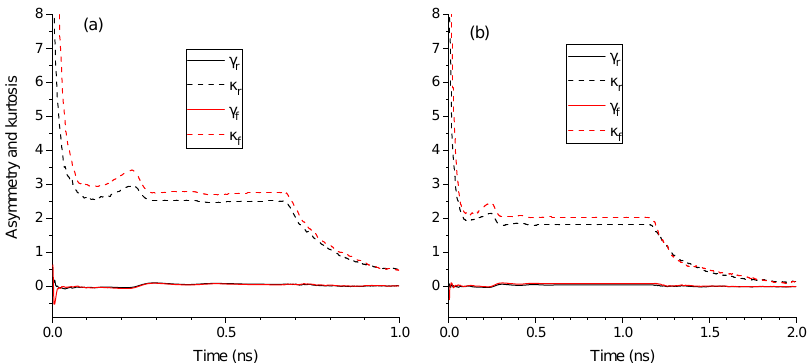
Figure 4. Asymmetry and kurtosis coefficients of the phase as a function of time for ( a ) T = 1 ns, and ( b ) T = 2 ns. Asymmetry and kurtosis coefficients are plotted with solid and dashed lines, respectively. Results for random and fixed initial conditions are plotted with black and red lines,